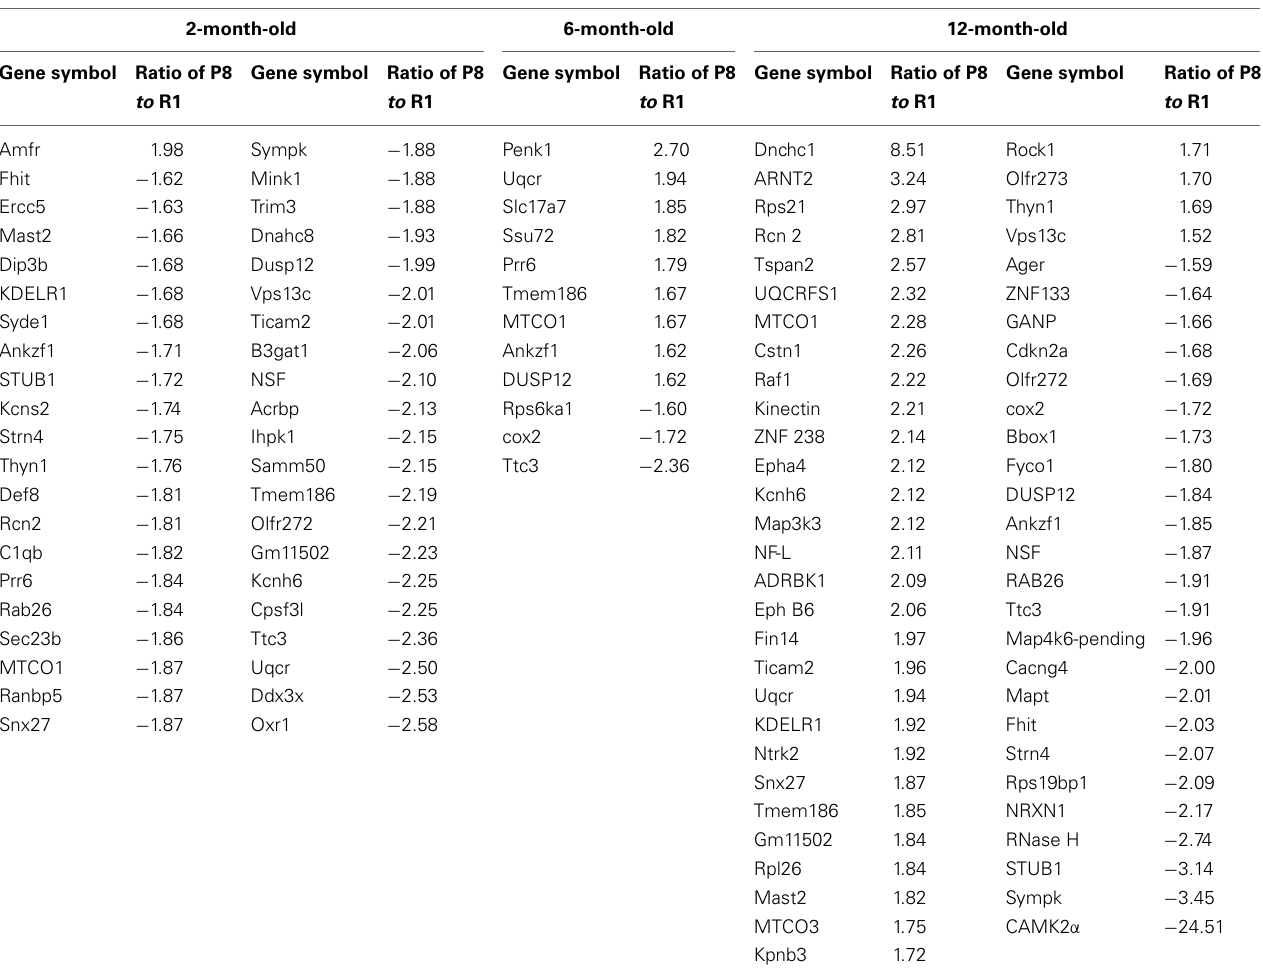
Table 1 | Differentially expressed genes in the hippocampus of SAMP8 and SAMR1 mice with aging*. 2-month-old